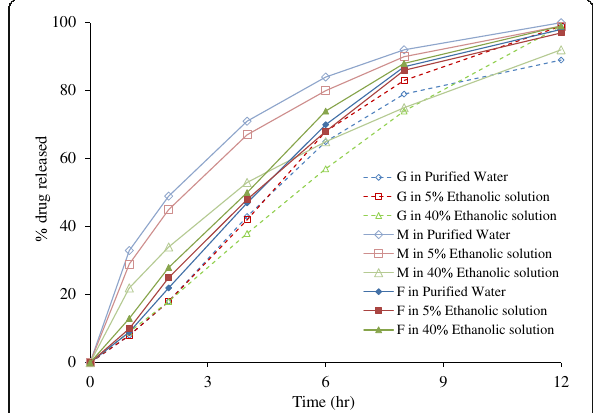
Fig. 18 Release profiles of gliclazide (G), metformin (M) and felodipine (F) from HPMC ER matrices in ethanolic media (data from reference (Levina et al.